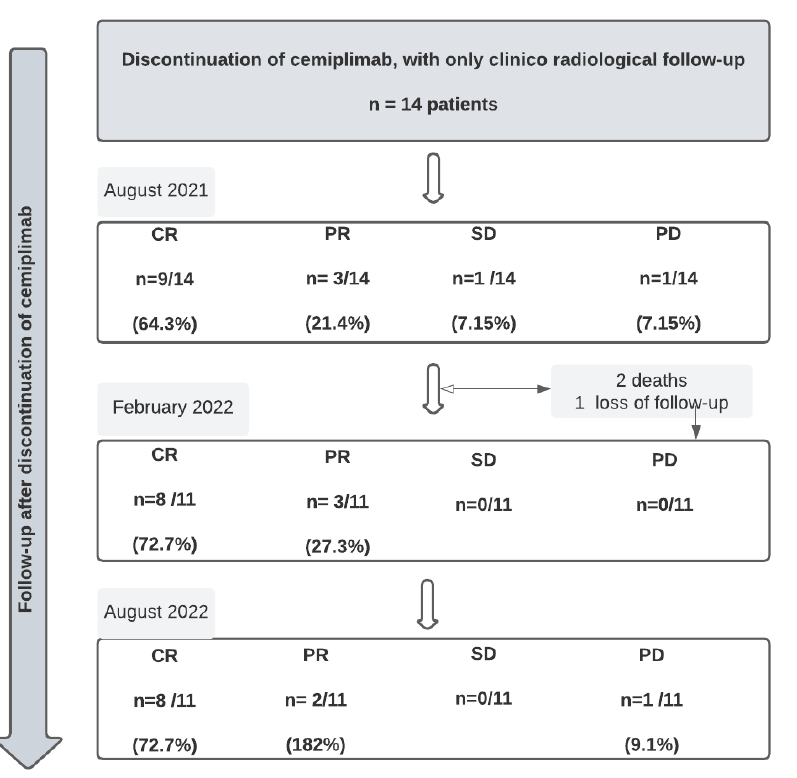
Figure 6. Follow-up of patients after discontinuation of cemiplimab ( CR = complete response; PR = partial response; SD = stable disease; PD = progressive disease).